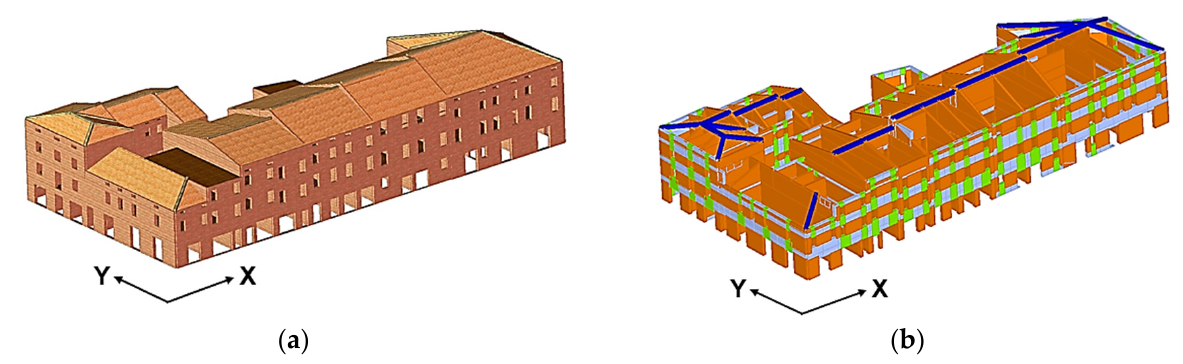
Figure 7. Representation of the case study aggregate: solid ( a ) and macro-element ( b ) models.